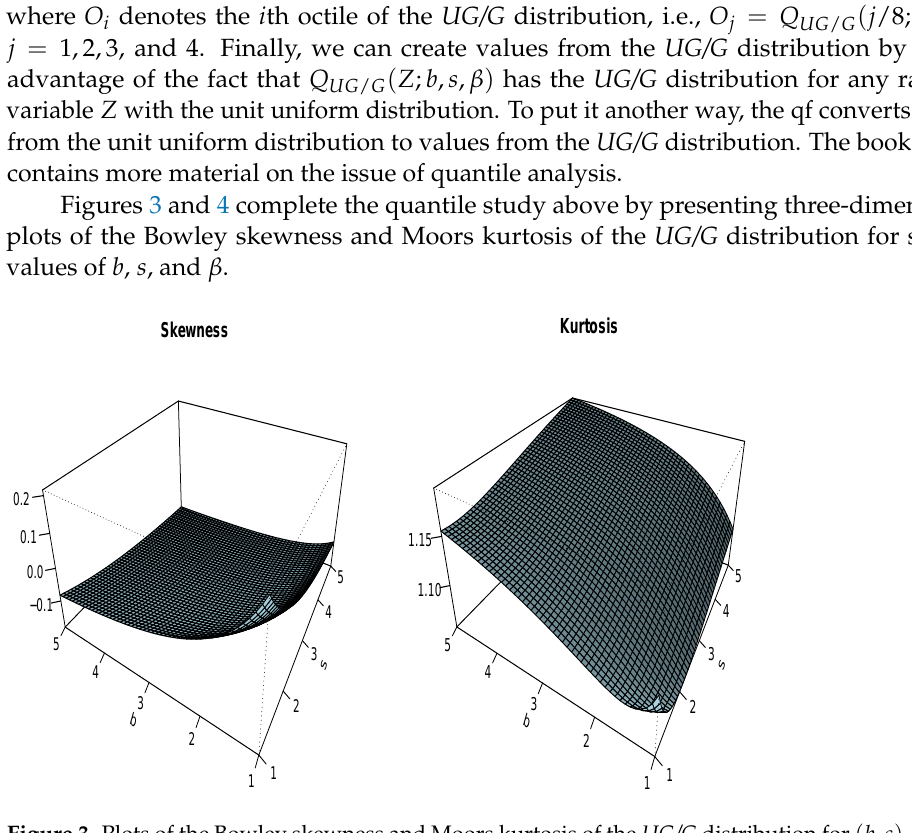
Figure 3. Plots of the Bowley skewness and Moors kurtosis of the UG/G distribution for ( b , s ) ∈ [ 1,5 ] 2 and β =